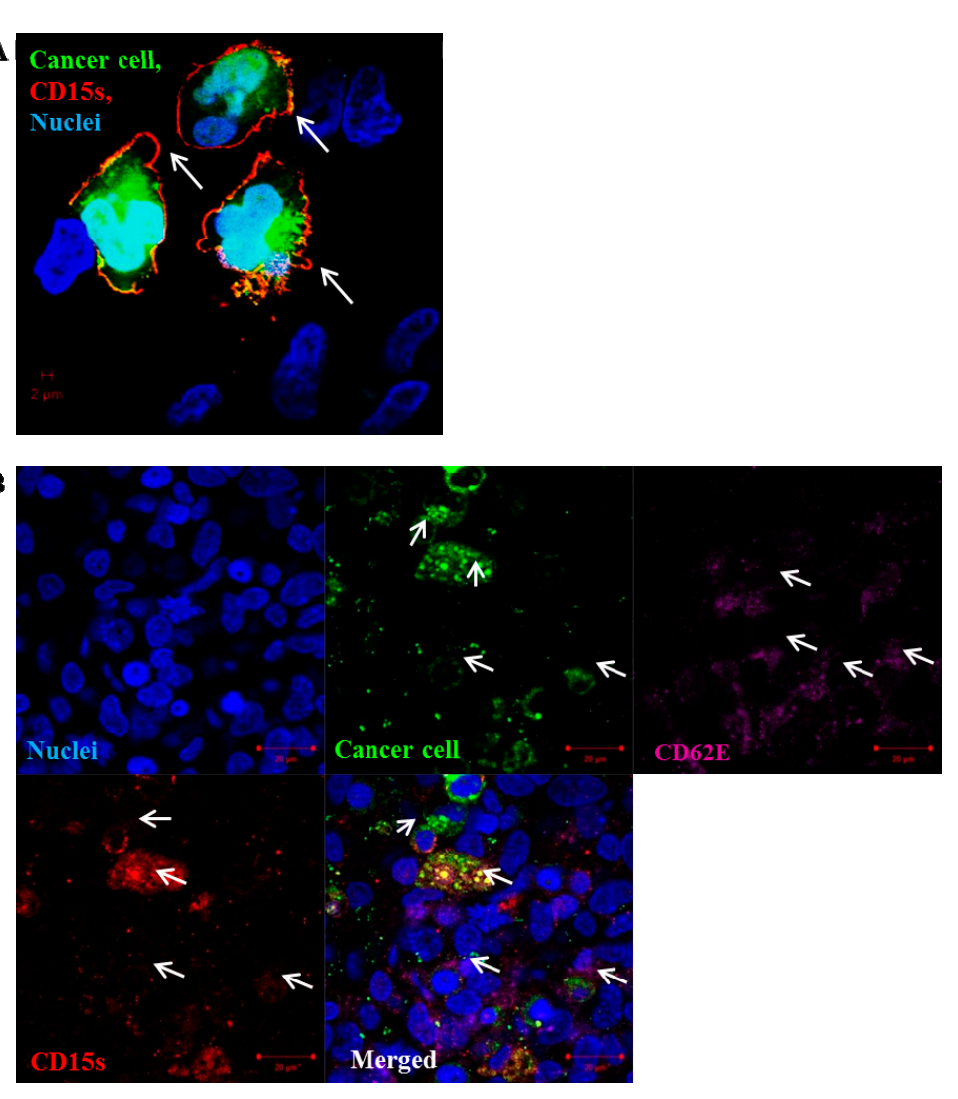
Figure 5. Localisation of CD15s on the surface of adherent SEBTA-001 cells at the site of adhesion. Confocal image of green fluorescently-labelled adherent brain to lung metastatic cancer cells (SEBTA-001) on a monolayer of activated hCMEC/D3 cells (blue). ( A ) Expression of CD15s (red) (white arrows) was seen on the edges of adherent cells SEBTA-001 (green) at the site of adhesion on brain endothelial cells; ( B ) expression of CD15s (red) (white arrows) was observed on surface of adherent cancer cells SEBTA-001 (green) and CD62E (purple) (white arrows) was seen on the monolayer of activated brain endothelial cells (hCMEC/D3) at adhesion site of cancer cell–brain endothelium. Scale bar = 20 µm.